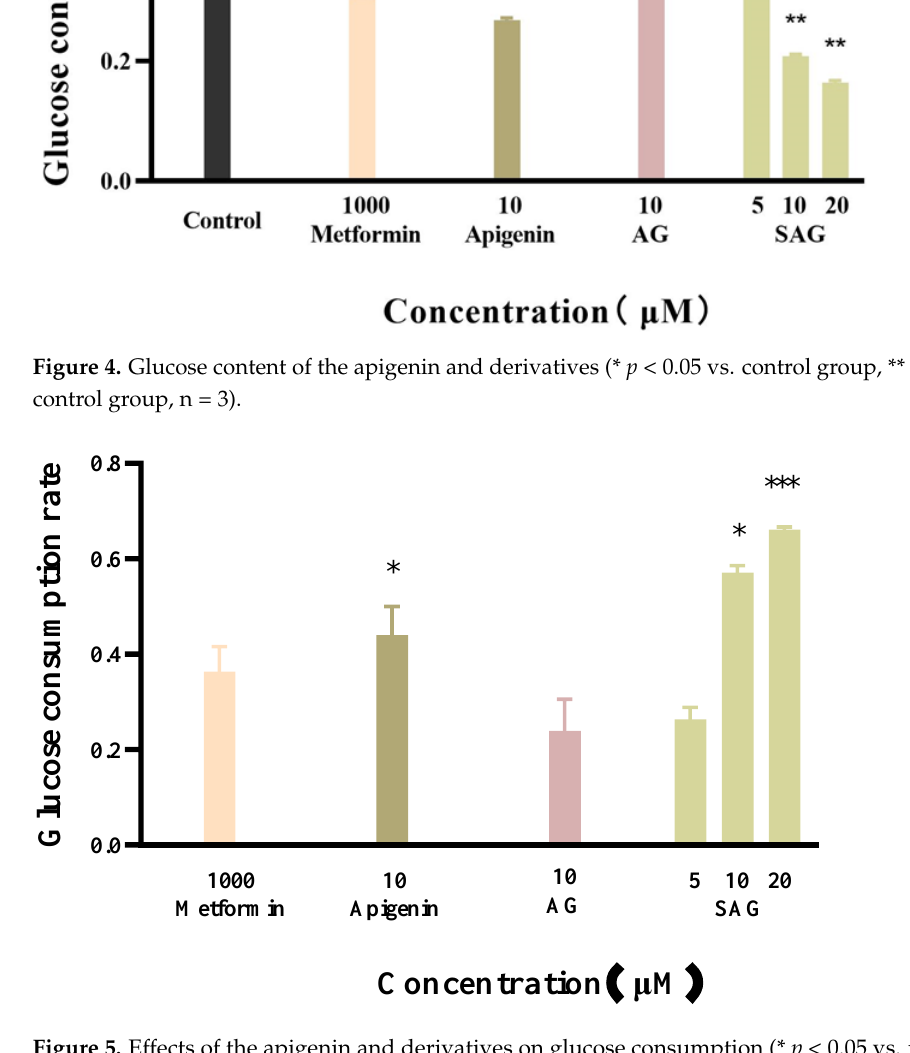
Figure 5. Effects of the apigenin and derivatives on glucose consumption （ * p < 0.05 vs. metformin group, *** p < 0.001 vs. metformin group, n = 3.